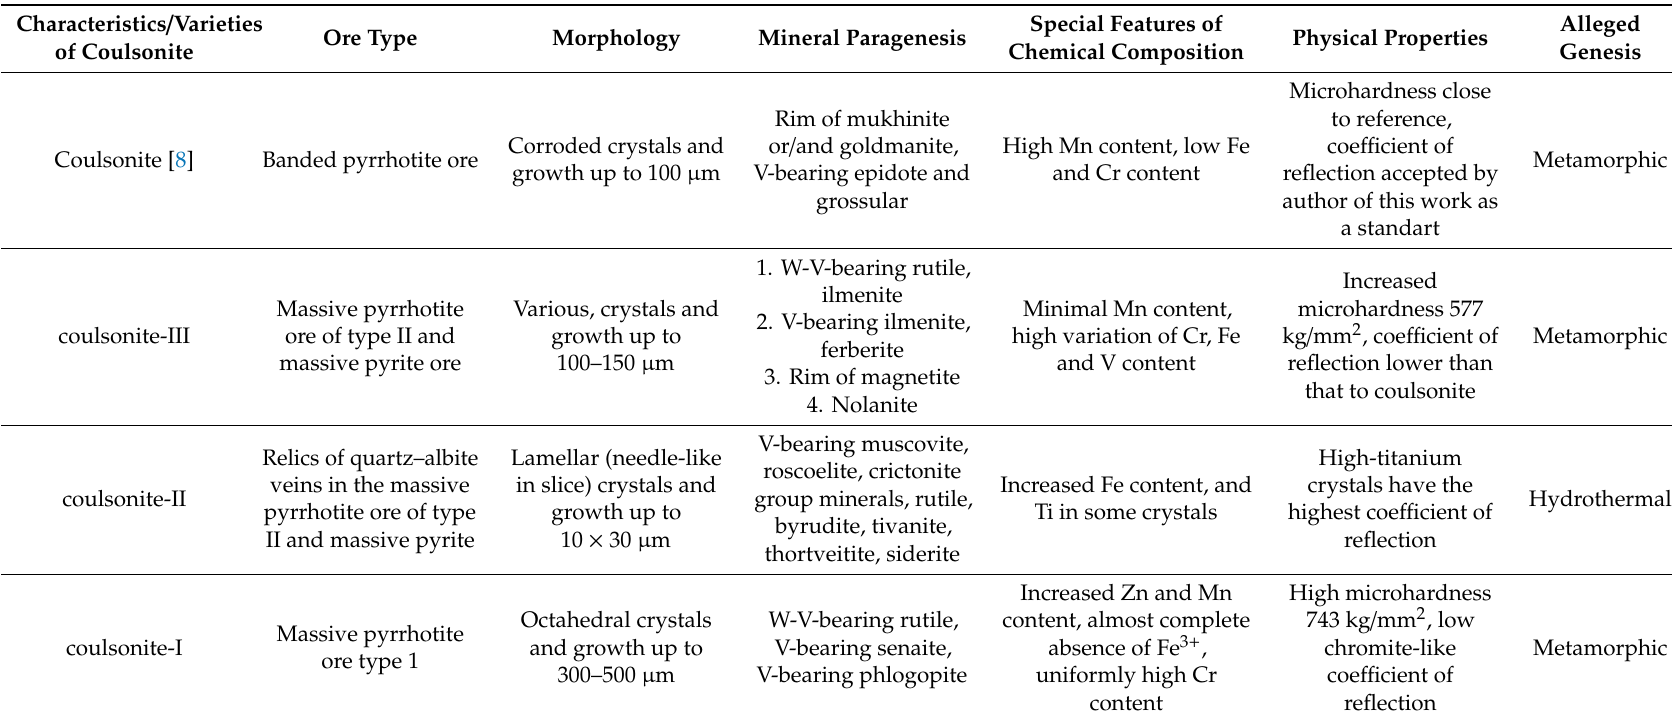
Table 1. Comparison of coulsonite varieties in massive sulfide ore of the Kola